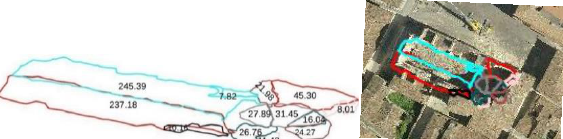
Figure 11. Outline of each missing segment of a building and their areas are annotated in m 2 (left) and superimposed on the corresponding building in post-event